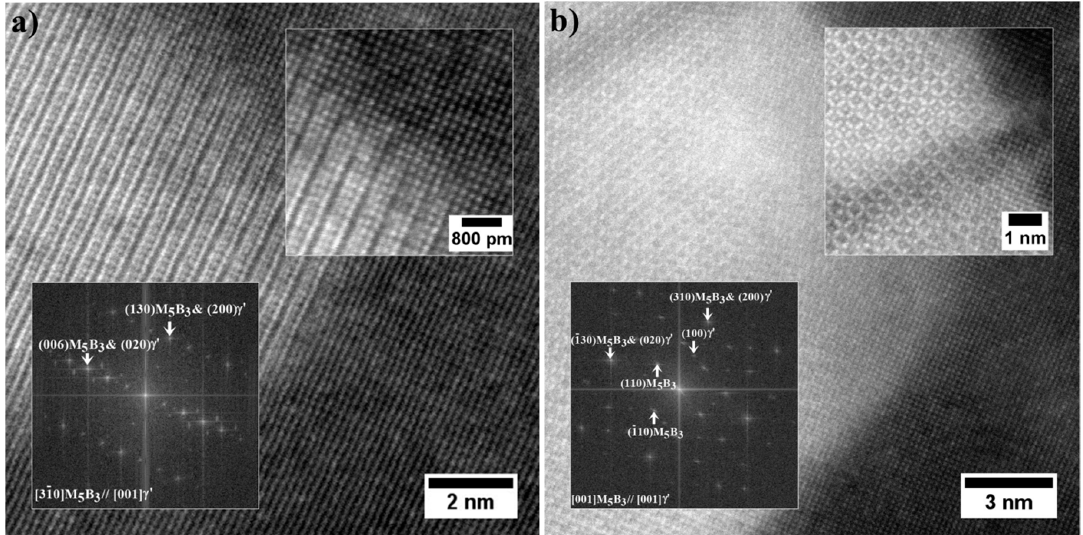
Figure 12. Nanostructure of the M 5 B 3 boride with corresponding Fast Fourier Transformation (FFT) image: ( a ) Zone axis [310 ] M 5 B 3 ; ( b ) Zone axis [001]M 5 B 3 , HRSTEM-HAADF.